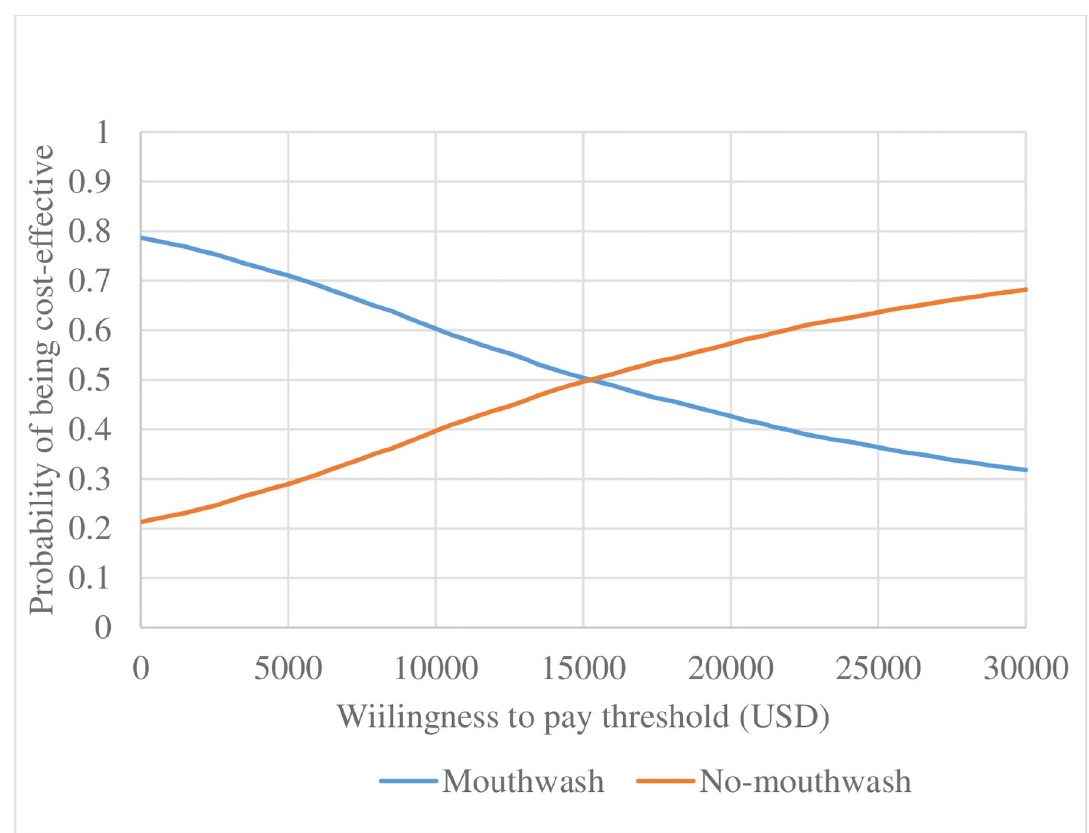
Fig 4. Cost-effectiveness acceptability curve (in the absence of